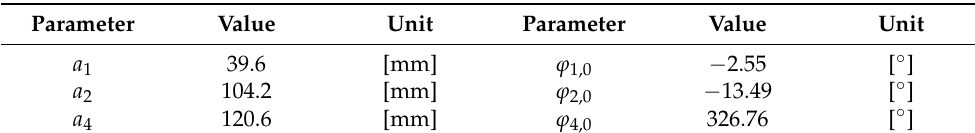
Table 3. Results of the synthesis of the mechanism. Link lengths to the left, link orientation at configuration 0 to the right.